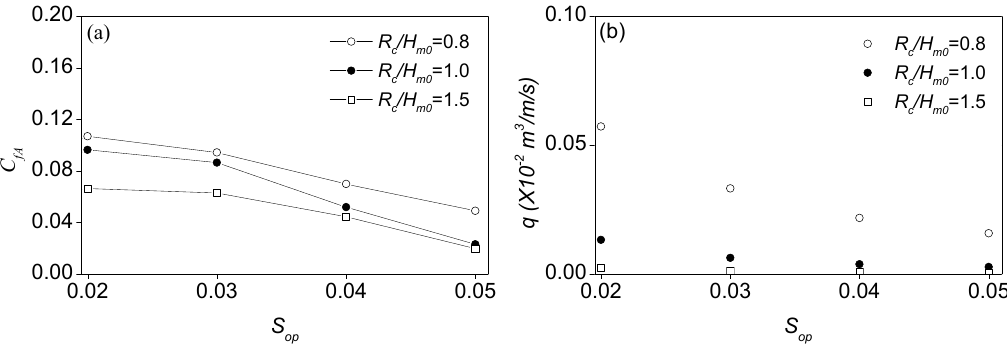
S and C ( a ), q ( b ) simulated by the SWASH model. Figure 5. Relationship between op fA Figure 5. Relationship between S op and C fA ( a ), q ( b ) simulated by the SWASH C fA